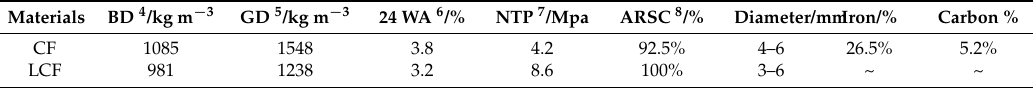
Table 2. Commercial Fe-C ceramic filler (CF) and commercial lightweight ceramic filler